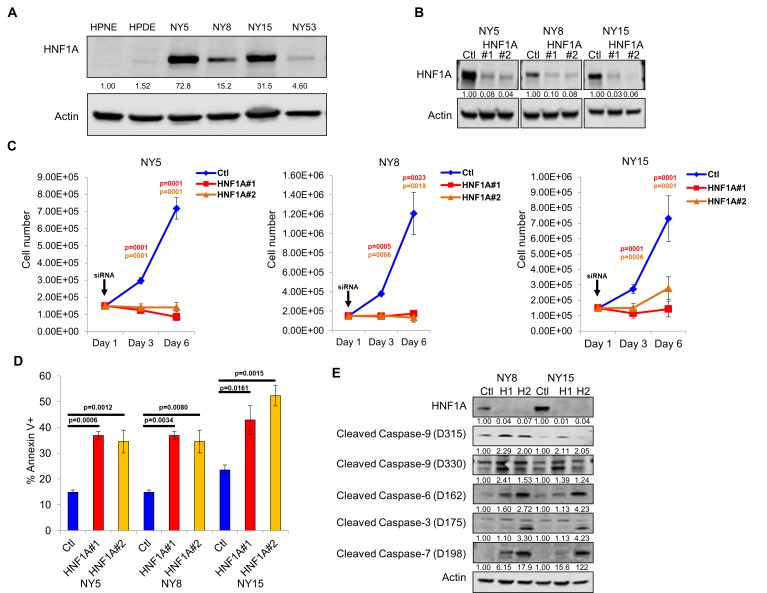
Knockdown of HNF1A in primary PDA cells inhibits growth in vitro.(A) Western blot analysis of HNF1A expression in a panel of primary PDA lines compared to immortalized pancreatic ductal cell line HPNE and HPDE. Quantitation of HNF1A protein is indicated below the respective blots. (B) Western blot of NY5, NY8, and NY15 cells transfected with non-targeting (Ctl) or HNF1A-targeting siRNA for 3 days, showing effective depletion of HNF1A protein by RNAi. Quantitation of HNF1A protein is indicated below the respective blots. (C) 1.5 × 105 PDA cells were transfected with control (Ctl) or HNF1A-targeting siRNA (Day 1). Cells were collected and manually counted 3 and 6 days after transfection (n = 3). Statistical difference was determined by one-way ANOVA with Dunnett’s multiple comparisons test. Red and green p values indicate Ctl vs. HNF1A#1 or #2, respectively. (D) Annexin V staining was performed on NY5, NY8, and NY15 cells transfected with control (Ctl) or HNF1A-targeting siRNA (H1, H2) for 3 days. The amount of apoptotic (annexin V+) cells are quantitated (n = 4). Statistical difference was determined by one-way ANOVA with Dunnett’s multiple comparisons test, with p values relative to the control siRNA group indicated. (E) Western blot analysis of cleaved caspases in NY8 and NY15 cells following HNF1A-knockdown (3 days). Actin serves as a loading control. Quantitation of proteins is indicated below the respective blots. Related data can be found in Figure 2—figure supplement 1.10.7554/eLife.33947.010Figure 2—source data 1.Quantitation of PDA cell growth and apoptosis following HNF1A knockdown.10.7554/eLife.33947.011Figure 2—source data 2.Quantitative PCR analysis of HNF1A mRNA in PDA cells and histology score of HNF1A staining in normal and neoplastic ducts..